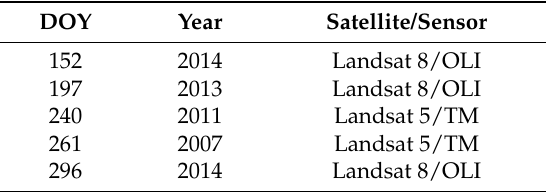
Table 1. Overview of Landsat data (path: 130, row: 37) used in this